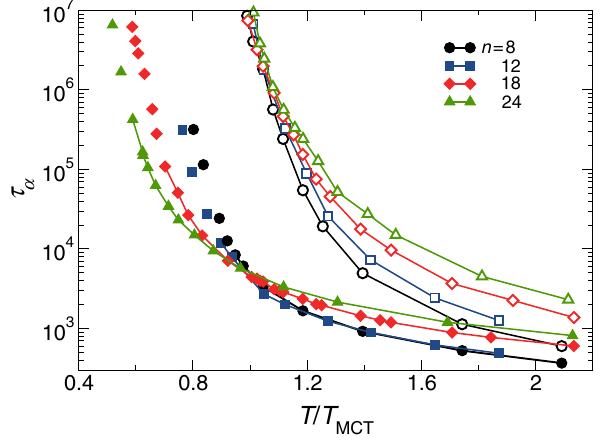
FIG. 8. Relaxation times for continuously polydisperse systems of repulsive soft spheres with different softness exponents n ¼ 8 , 12, 18, and 24. Temperatures are scaled by T to allow direct MCT ¼ 0 . 143 , 0.267, 0.468, comparison between models, with T MCT and 0.662, respectively. Open symbols represent the standard Monte Carlo dynamics, and closed symbols show the swap algorithm, for which unconnected symbols represent structurally unstable state points where only a rough estimate of τ α is obtained in short simulations. A larger n yields better efficiency and better structural stability.